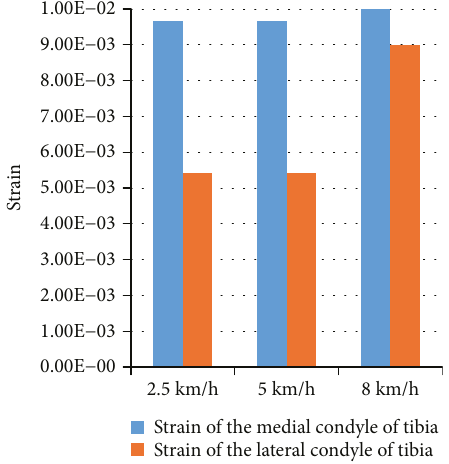
Figure 7: Strain peaks of the medial tibia at the varied impact speeds.